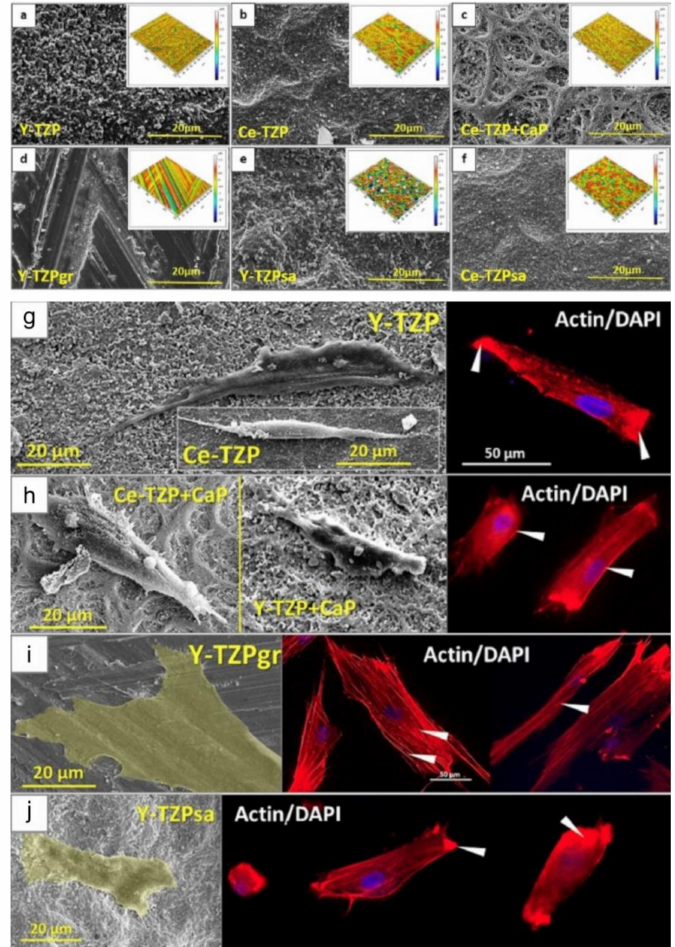
Figure 3. Different ZrO 2 -surfaces morphologies modified by varied surface treatments ( a – f ). Micro- scopies using electron microscopy (SEM) and confocal microscopy showing the different responses of osteoprogenitor cells regarding morphology and nuclei position on four different ZrO 2 -modified surfaces. The cells presented an elongated morphology in some surfaces ( g,h ) and a flattened mor- phology in other topographies ( i , j ). Showing, as reported in the study, that surface morphology characteristics in zirconia are more important for cell evolution and consequent proliferation than properties such as roughness and wettability. Reprinted and adapted with permission under Creative Commons Attribution 4.0 International License, reference